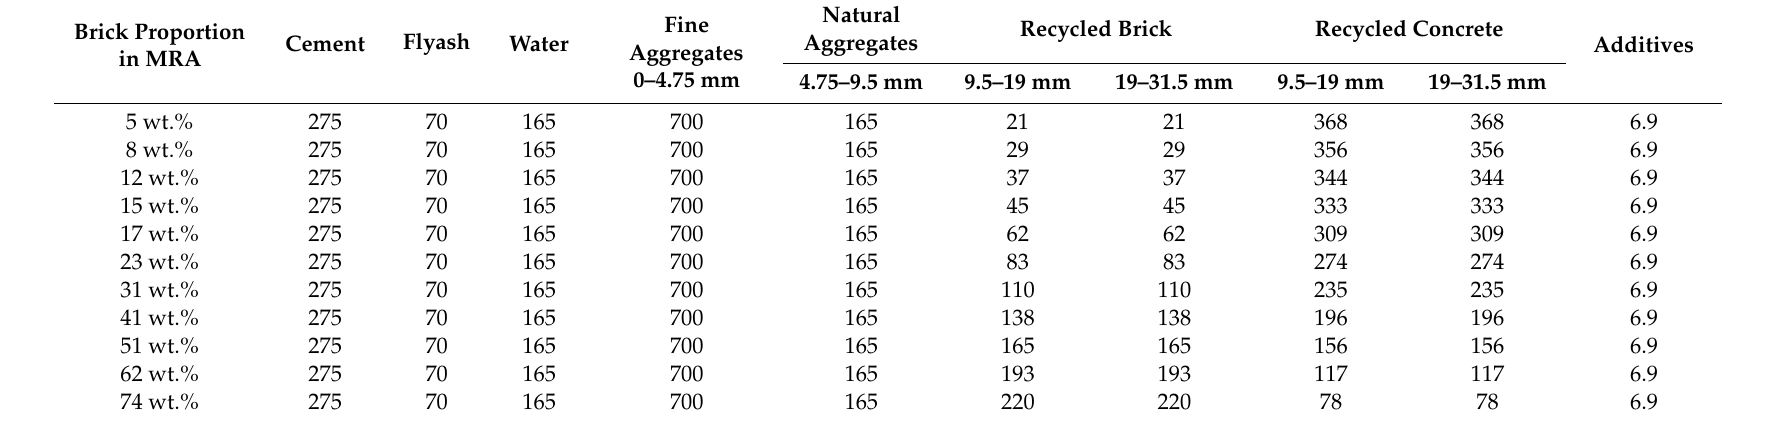
Table 2. Recycled brick proportion of the concrete mixtures (kg / m 3